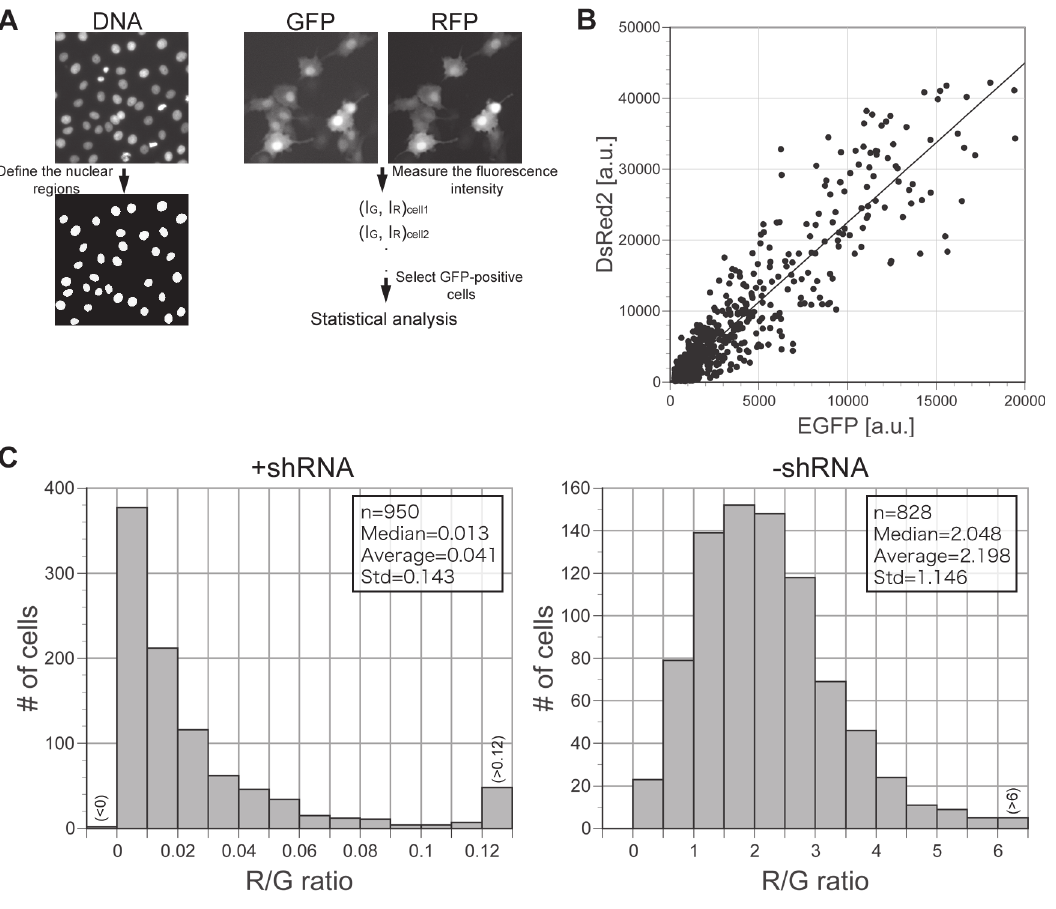
Figure 2. Image analysis of dual fluorescence assay. ( A ) Scheme of image analysis. Interphase nuclei are defined from DNA-staining images. Although the expressed fluorescence is distributed throughout the cell, regions of interest defined by the DNA staining are convenient for measurement of the GFP and RFP intensities of individual cells. The fluorescence intensities were thresholded, averaged over the region of interest and subjected to statistical analysis (see Materials and Methods in detail). ( B ) Scatter plot of green and red intensities. Rat2 cells were co-transfected with pSHIN-G empty plus pREFLECT-R(DsR)-Vim-T5. Linear correlation between green and red fluorescence was observed over a wide range of expression levels. ( C ) Histograms of the ratios of red intensity to the green intensity (R/G). Left, co-transfection of pSHIN- G-Vim-T5 plus pREFLECT-R(DsR)-Vim-T5; right, co-transfection of pSHIN-G empty plus pREFLECT-R(DsR)-Vim-T5. The right histogram was created from the same data set as for Figure 2B. The first left bins represent the numbers of the R/G ratio lower than zero, while the last right bins represent the numbers of the values higher than the indicated maximum (0.12 and 6 for left and right histograms, respectively). Upon shRNA expression (left histogram), the R/G ratios were significantly reduced because of RNAi of RFP. The medians, averages and standard deviations (Std) of the R/G ratios, as well as the numbers of analyzed cells (n), are shown in the